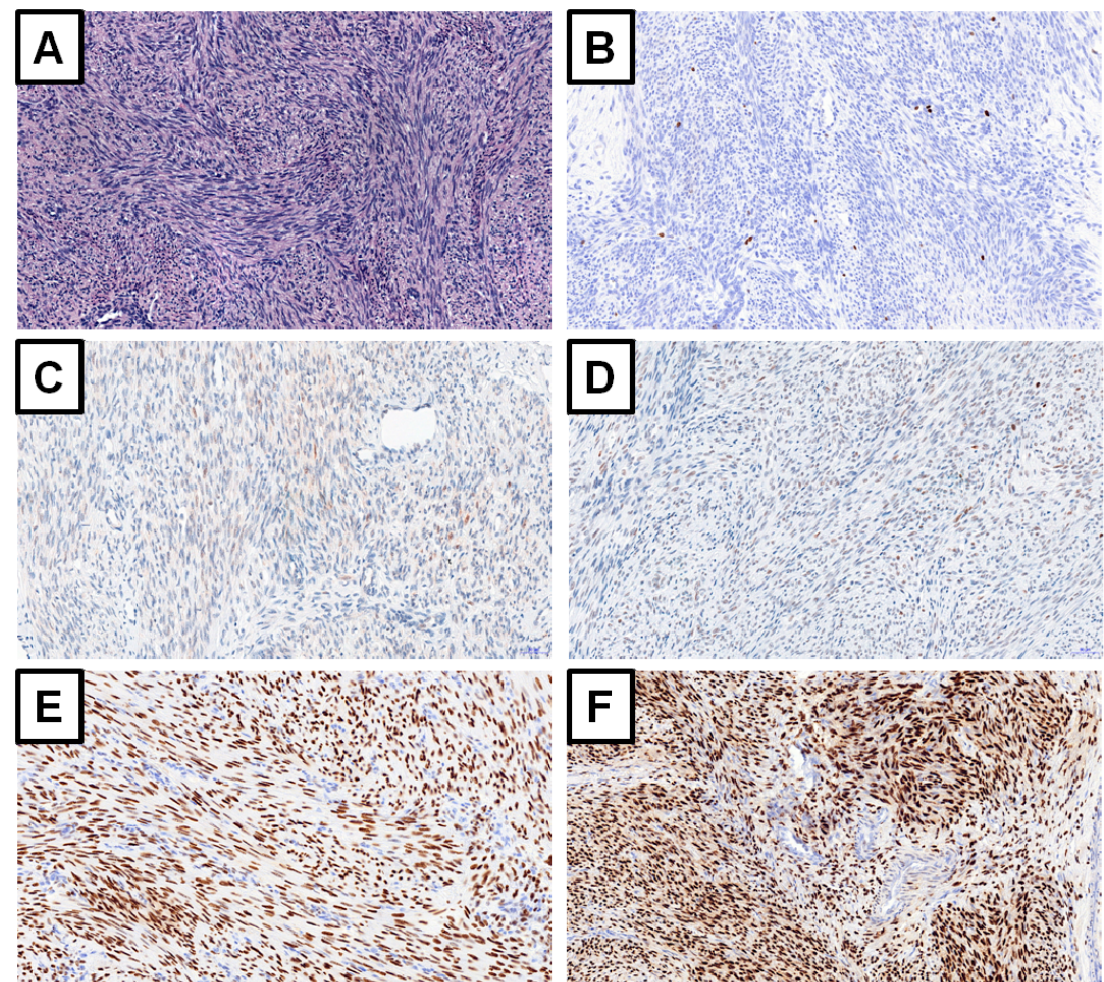
Figure 1. Leiomyoma. ( A ) Topographical staining hematoxylin and eosin. Immunochistochemical expression of ( B ) Ki-67 antigen, ( C ) p53 protein, ( D ) p16 protein, ( E ) estrogen and ( F ) progesteron receptors. Magnification ×20.